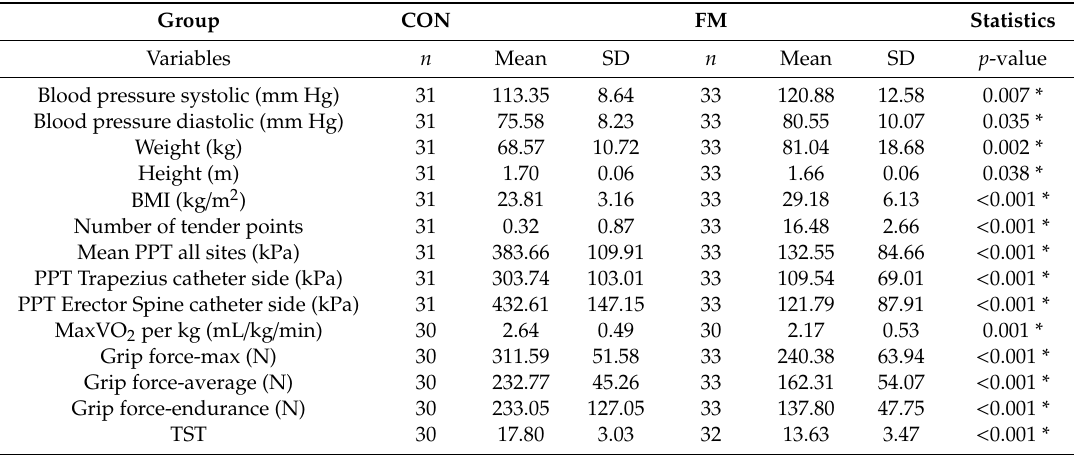
Table 2. Variables obtained at the clinical